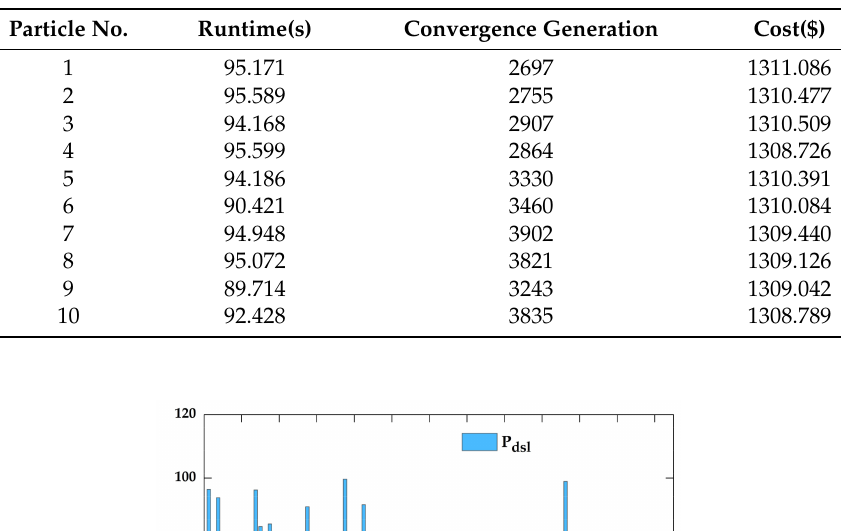
Table 2. Numerical Results by the PSO method.